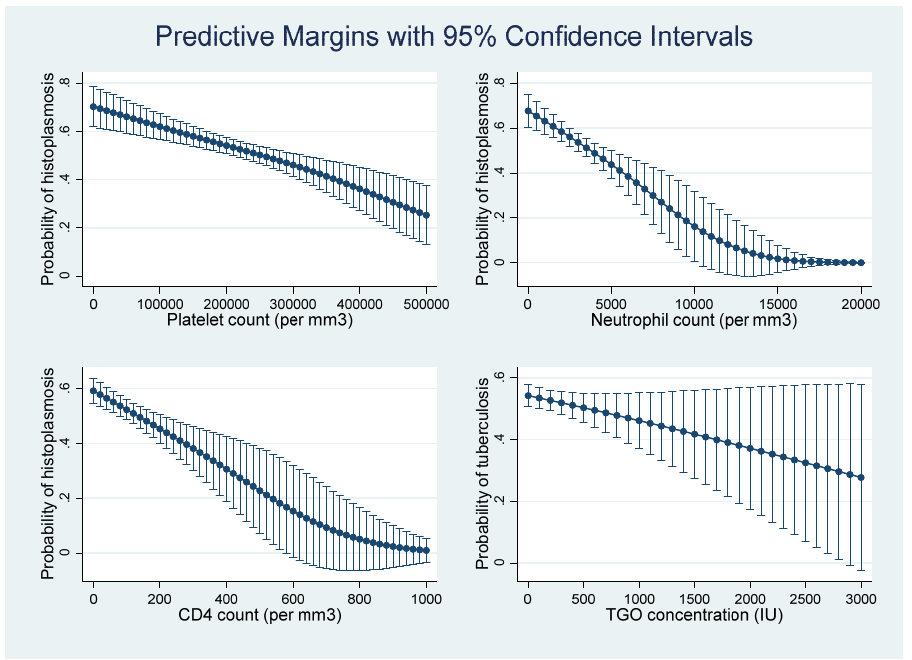
Figure 3. The evolution of the probability of having disseminated histoplasmosis, rather than tuber- culosis, for CD4, neutrophil, and platelet counts, and Aspartate-Amino-Transferase concentration.